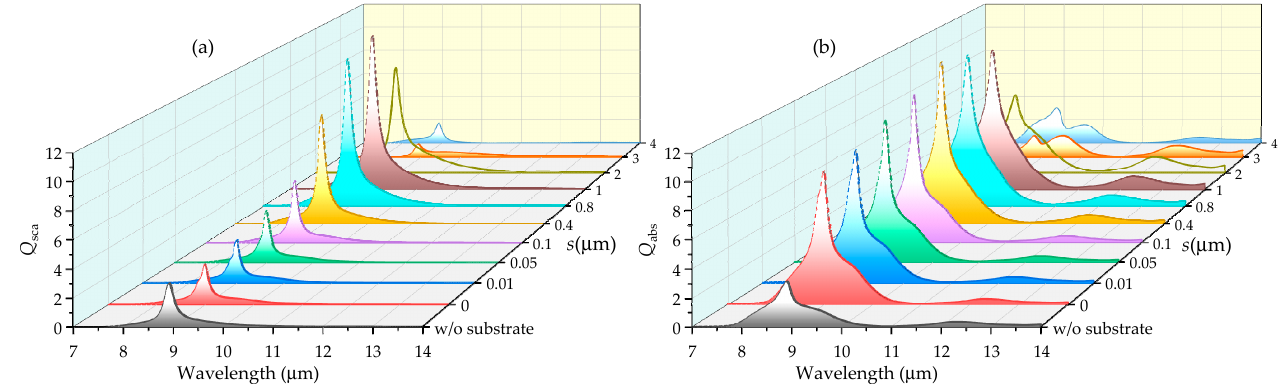
Figure 4. Mid-infrared properties of a SiO 2 sphere on the Al substrate versus the wavelength and particle-to-substrate distance s, where curves of different colors correspond to different distances s of particles to the substrate : ( a ) scattering and ( b ) absorption efficiencies. For convenience, the efficiencies of a free particle without the substrate Q sca,0 and Q abs,0 are also shown. The radius of the SiO 2 sphere is 1 µm.